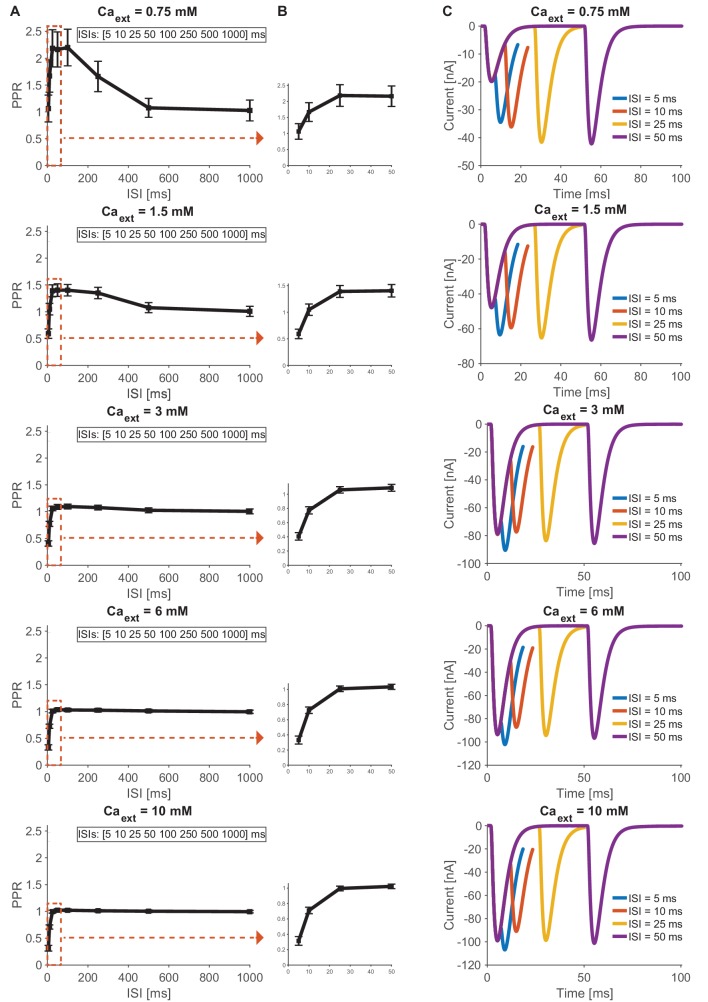
Simulation based time course predictions of paired-pulse STF recovery for different interstimulus intervals across different Ca2+ concentrations (0.75–10 mM).(A) Estimated PPRs for 0.75, 1.5, 3, 6 and 10 mM extracellular Ca2+ (from top to bottom) as a function of interstimulus interval (5, 10, 25, 50, 100, 250, 500 and 1000 ms). STF can be detected at low (0.75 mM) and physiological (1.5 mM) Ca2+ concentrations and decays after approximately 100 ms, no STF can be detected at high (3–10 mM) Ca2+ concentrations (starting with PPR values below 0.5 at 5 ms and increasing to PPR values around one for intervals above 25 ms). Regions of interest indicated by dashed red square are shown as a close-up in next panel. (B) Estimated paired-pulse ratio values (PPR) for Ca2+ concentrations (0.75–10 mM) 0.75, 1.5, 3, 6 and 10 mM extracellular Ca2+ (from top to bottom) as a function of their interstimulus interval (5, 10, 25, 50 ms). (C) Examples of average traces from paired-pulse simulations at different (0.75–10 mM) extracellular Ca2+ (from top to bottom) for 5 ms (blue), 10 ms (red), 25 ms (yellow) and 50 ms (purple) interstimulus intervals. Results from simulations (means and SDs) can be found in the accompanying source data file (Figure 7—source data 1).